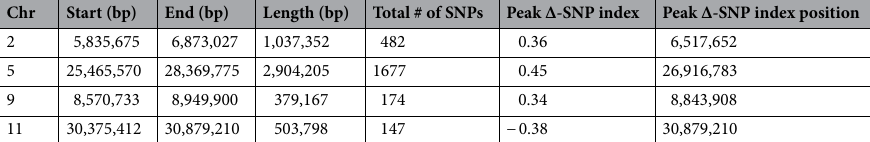
Table 2. Quantitative trait loci identified for gummy stem blight resistance by comparing the susceptible and resistant bulks of the Sugar Baby × PI 189225 F 2:3 population. Locations are based on the C. lanatus 91703_v2 genome sequence (Guo et al . 24